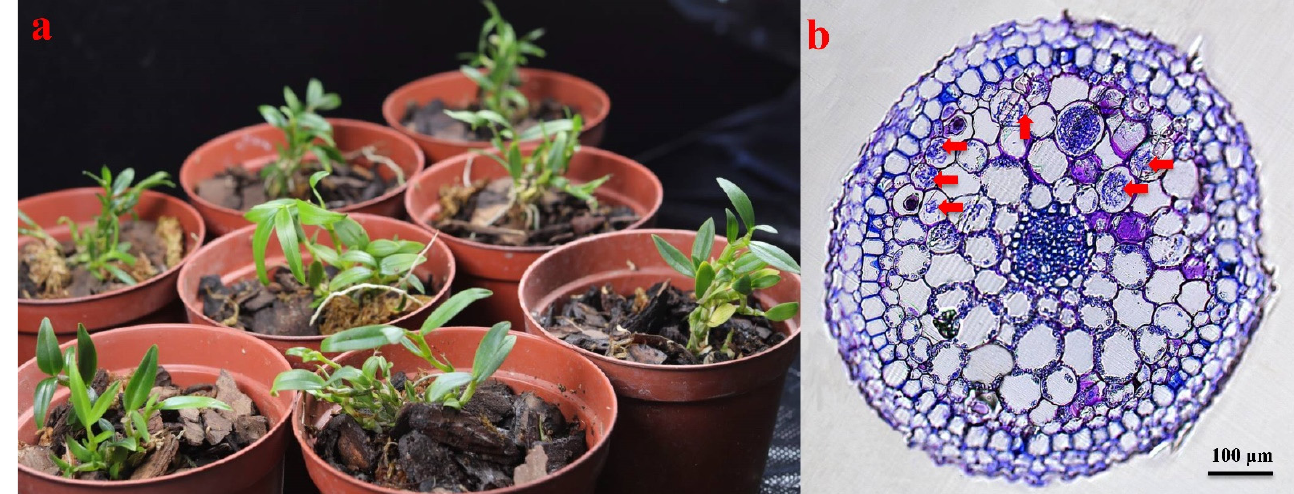
Figure 1. ( a ) The ex situ seedling baiting experiments conducted in this study, in which in vitro- produced seedlings of Dendrobium officinale were potted with substrates (e.g., litters, barks and mosses) collected from 6 original habitats of D. officinale. ( b ) Cross-section of D. officinale seedling root at 75 days after transplantation showing root colonization by orchid mycorrhizal fungi in DXLM treatment (red arrows indicating